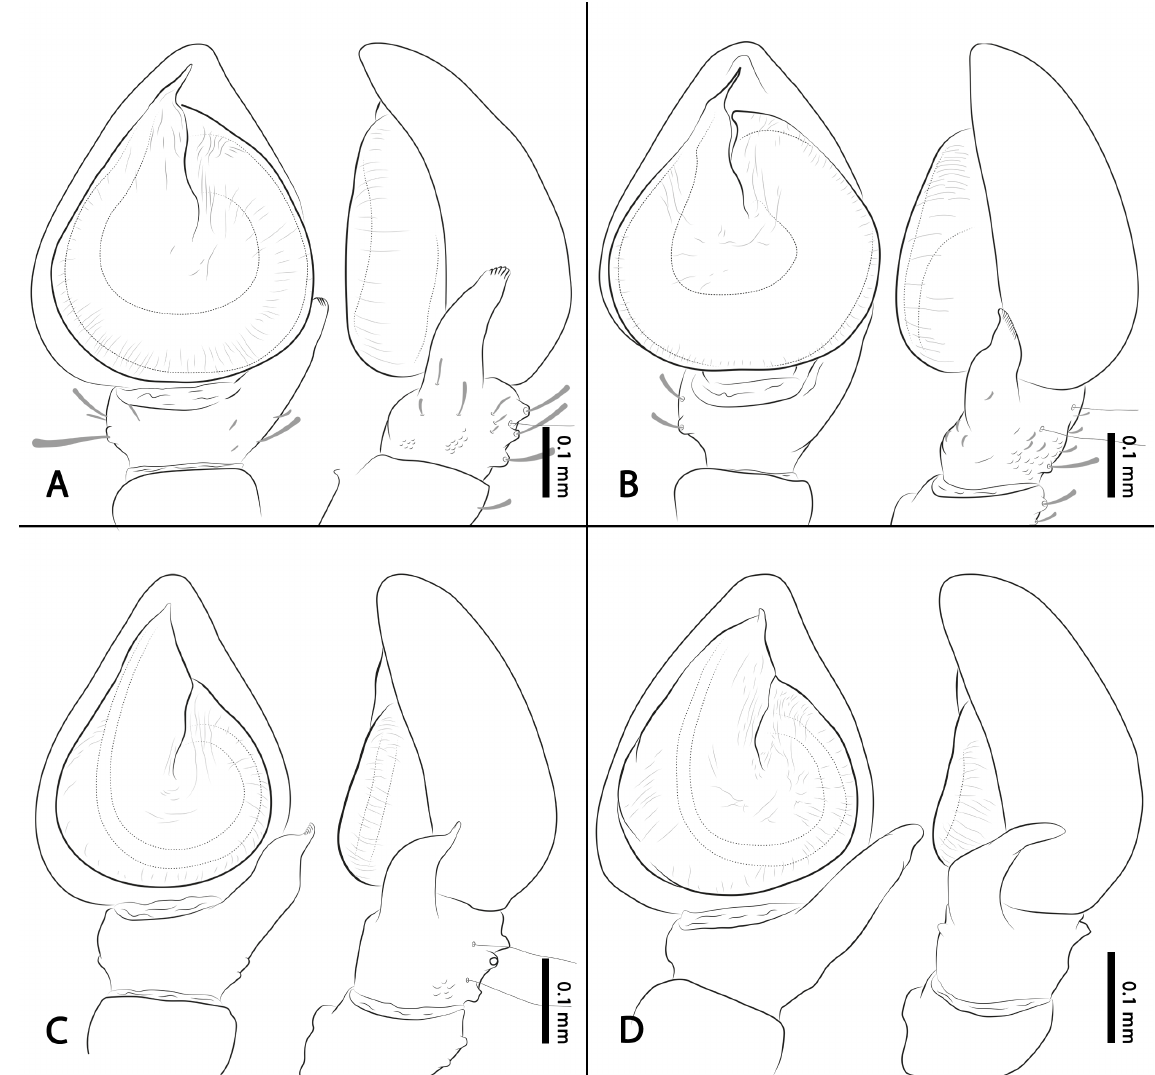
Fig. 19. Illustrations of the left male palp in ventral and retrolateral view. A . Kryptochroma pentacantha (Mello-Leitão, 1929) gen. et comb. nov. ((MCTP 25762). B . K. quadrata Machado & Viecelli gen. et sp. nov., holotype (MPEG 22673). C . K. quinquetuberculata (Taczanowski, 1872) gen. et comb. nov. (IBSP 46712). D . Kryptochroma renipalpis (Mello-Leitão, 1929) gen. et comb. nov. (MCTP